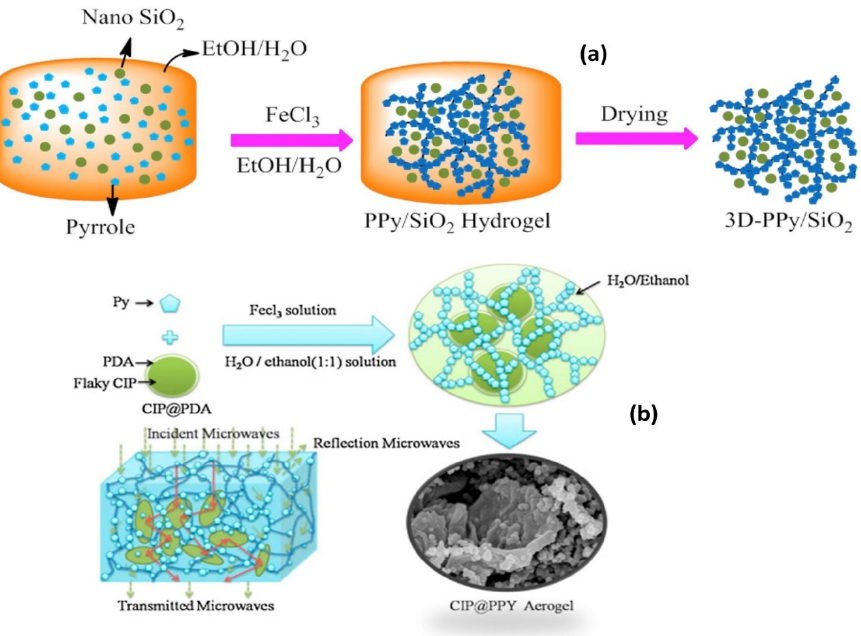
Figure 18. ( a ) The preparation of PPy/SiO 2 composites. ( b ) Schematic representation of the formation of CIP@PPy aerogels and the interaction of the microwave within the composite. Reproduced with permission from [160,161]. Copyright 2015, Elsevier Ltd.